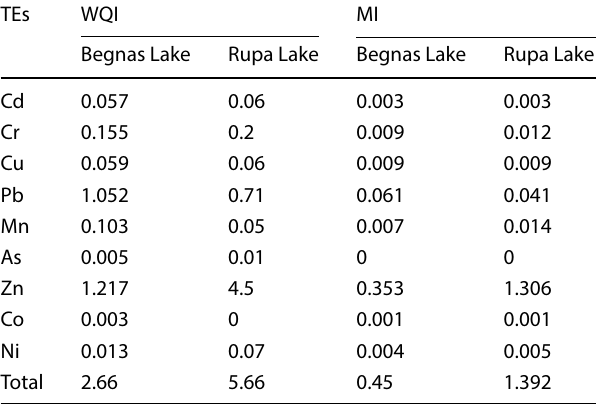
Table 5 Water quality index (WQI) and metal index (MI) of the Begnas Lake and Rupa Lake, Gandaki Province, Nepal